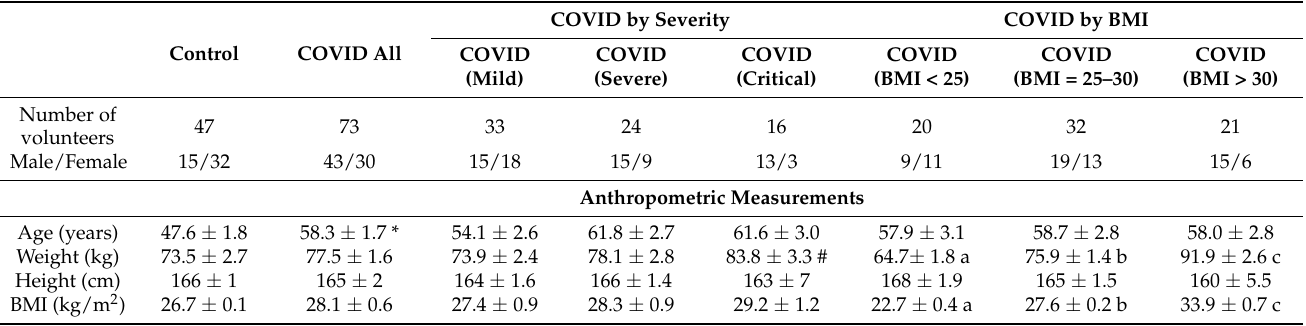
Table 1. Anthropometric measurements in control subjects and COVID-19 patients. Data were analyzed considering all the individuals (women and men together), and stratified by COVID-19 severity (mild, severe, or critical) or by body mass index (BMI) range. Data are mean ± SEM. Statistics: differences between stratified groups were analyzed by one-way ANOVA followed by least significant difference (LSD) post-hoc test, a (cid:54) = b (cid:54) = c ( p < 0.05). Student’s t test was used for single comparisons: *, COVID all vs Control, #, severe/critical vs mild COVID ( p < 0.05).